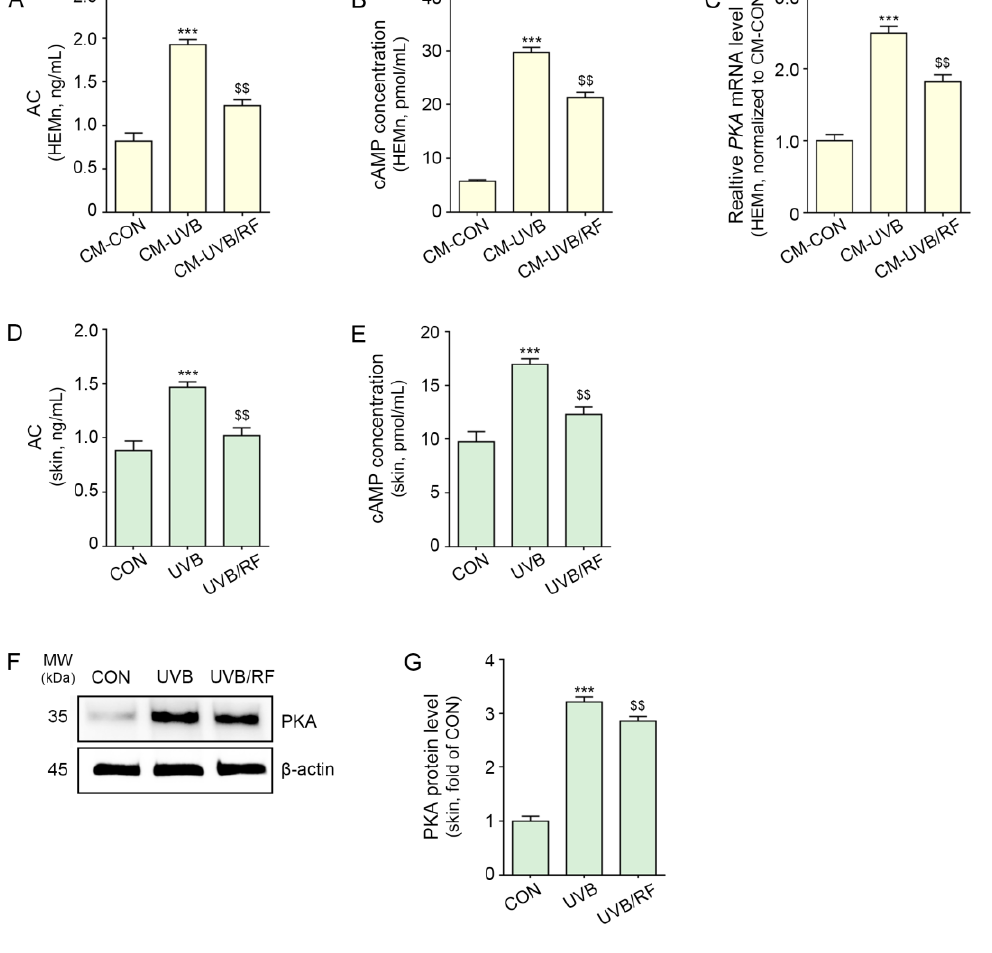
Figure 3. RF irradiation reduced the expression of AC/cAMP/PKA in CM-treated melanocytes and UVB-exposed mouse skin. ( A – C ) HEMn were treated with the supernatant of HEKn cells (CM-CON), UVB-exposed HEKn cells (CM-UVB), or UVB and RF-treated HEKn (CM-UVB/RF) for 48 h. ( A , B ) Changes in AC activity ( A ) and cAMP concentration ( B ) in CM-treated HEMn were measured by cAMP XP assay. ( C ) The mRNA levels of PKA in CM-treated HEMn were determined by qRT-PCR. ( D – G ) Mice were not exposed or exposed to UVB nine times for 5 min each for 14 d (CON or